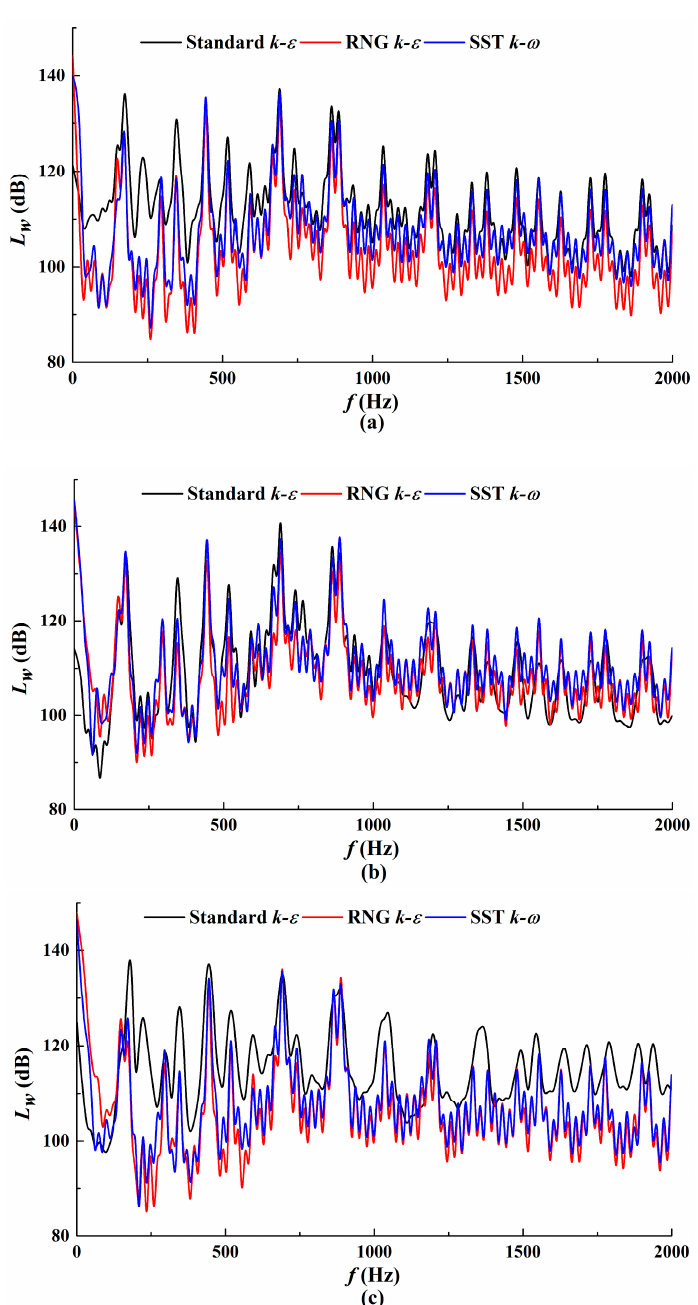
Figure 18. Spectrum of the radiated sound power at ( a ) 0.8 Q d , ( b ) 1.0 Q d , and ( c ) 1.2 Q d .